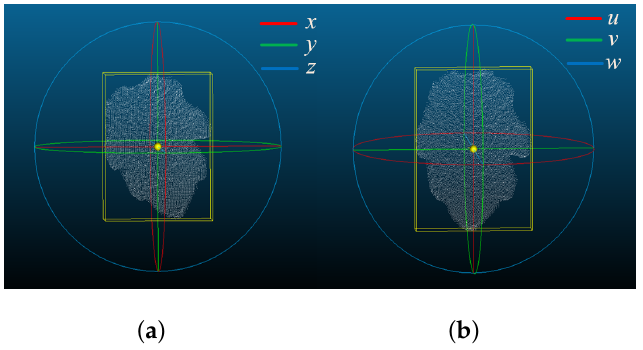
Figure 2. Coordinate system of leaf point cloud. ( a ) Original coordinate system of point cloud. ( b ) Processed coordinate system of point cloud.